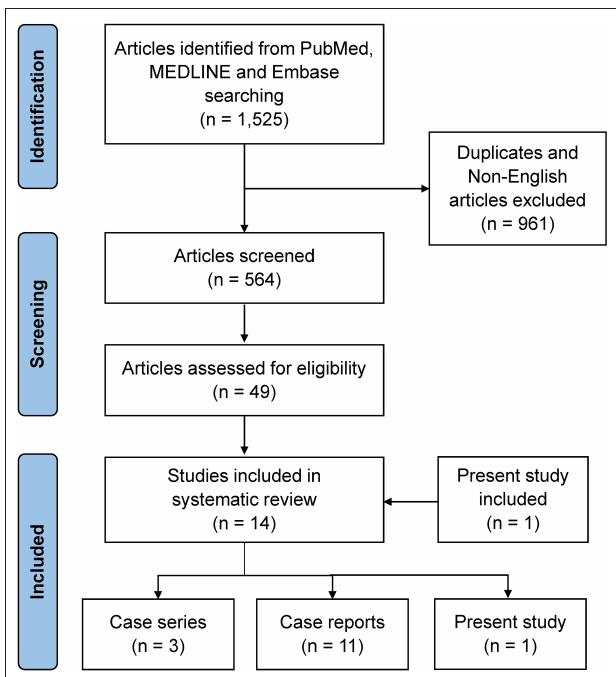
FIGURE 3 | Flow diagram of study selection based on the Preferred Reporting Items for Systematic Reviews and Meta-analyses (PRISMA) flowchart for the article selection process.